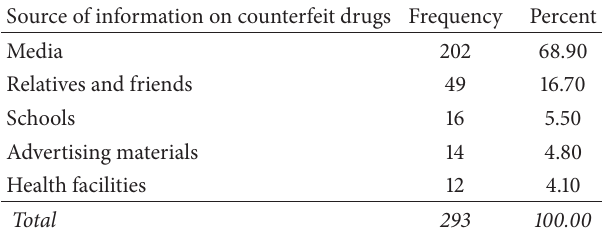
Table 3: Distribution of respondents according to source of infor- mation on counterfeit